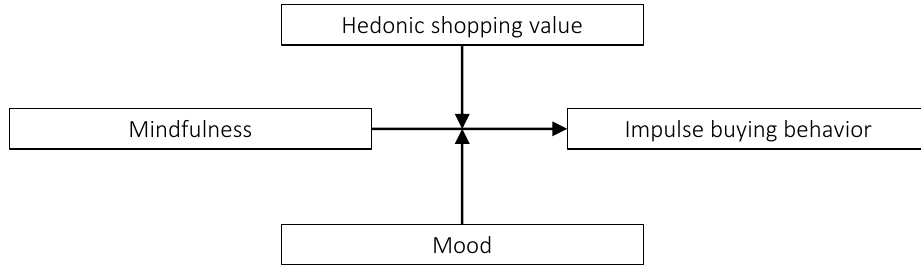
Figure 1. Conceptual model of the